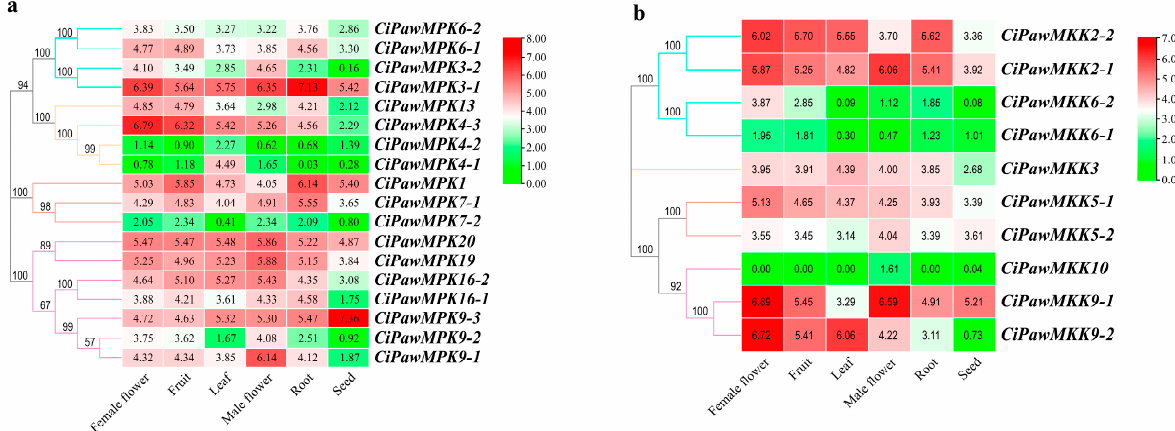
Figure 7. Expression of MPK ( a ) and MKK ( b ) genes in different organ samples of pecan.